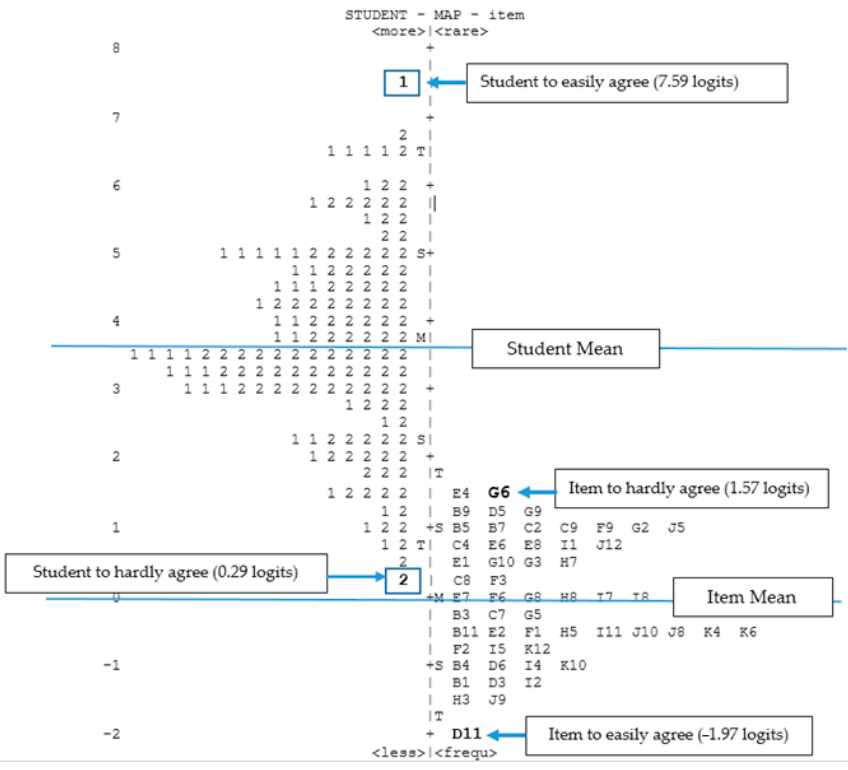
Figure 1. Item-individual map for 10IBLP −